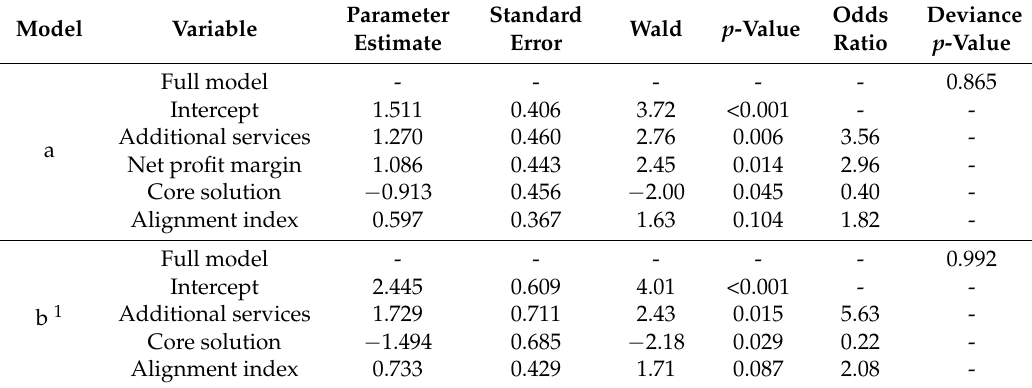
Table 5. Binary logistic regression models with relationship status as dependent variable (continued relationship = 1; terminated relationship = 0, with a continued relationship as reference event).